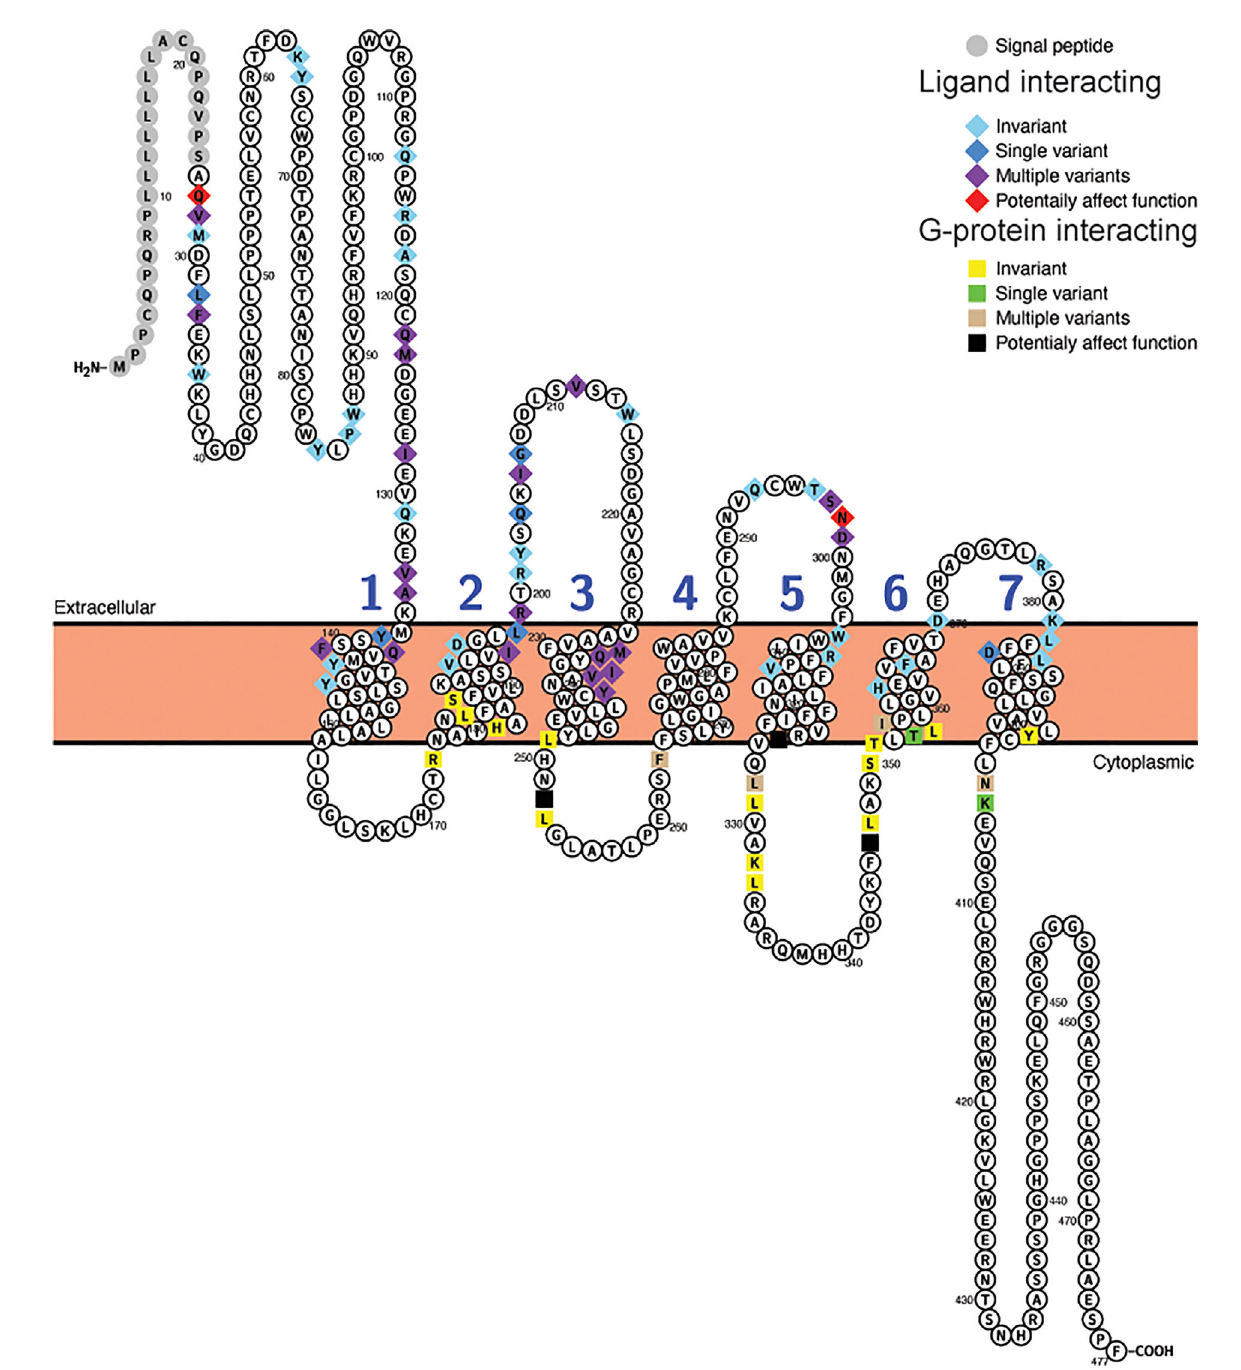
FIGURE 3 | Variability in ligand and G-protein interacting sites in mammalian glucagon receptors (Gcgr). Snake plot of the Gcgr protein sequences (Uniprot accession: GLR_HUMAN) generated with Protter (wlab.ethz.ch/protter/start/) (71). Extracellular regions are shown at the top, cytoplasmic regions at the bottom, and transmembrane domains between the two lines. Signal peptides and transmembrane domains are extracted from the Uniprot accession fi les for the proteins by Protter. Signal peptide resides are shown in gray. The transmembrane domains are numbered (1-7). Ligand interacting residues are shown as diamonds and G- protein interacting sites as squares. Variability in the ligand and G-protein interacting residues in the sequences from 78 mammalian species are displayed in different colors with light blue diamonds and yellow squares being invariant, dark blue diamonds and green squares only have one species varying, purple diamonds and tan squares representing sites that either vary in multiple species and/or have multiple amino acid states, while red diamonds and black squares identify sites that have a substitution that was predicted to “ Affect function ” by SIFT (67) and be “ Deleterious ” by PROVEAN (68).